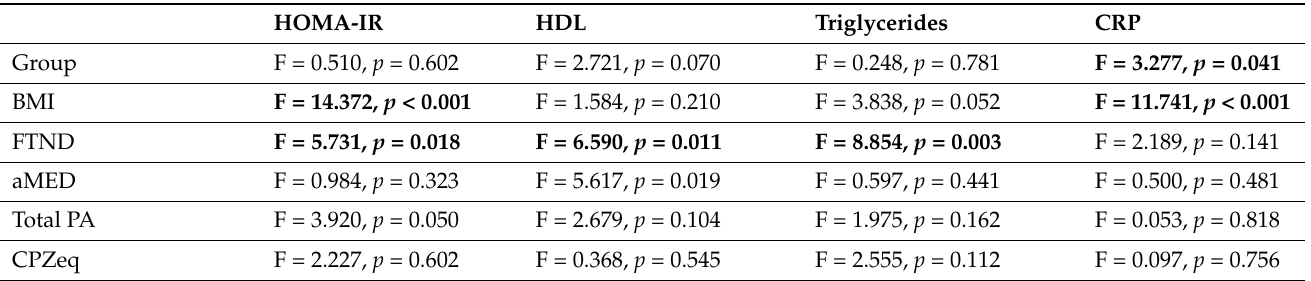
Table 3. Results of the analysis of covariance (ANCOVA) testing for between-group differences in biochemical parameters after adjustment for potential confounders.